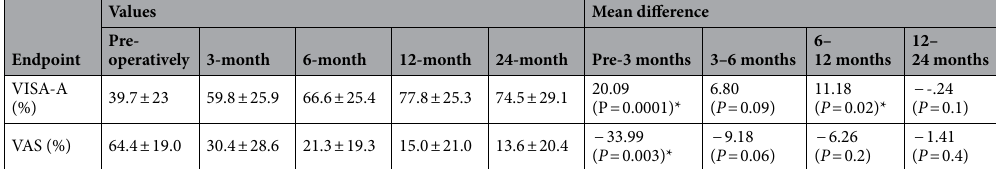
Table 3. Improvement of the VISA-A and VAS scores at the various follow-up appointments (*statistically significant following Bonferroni post-hoc